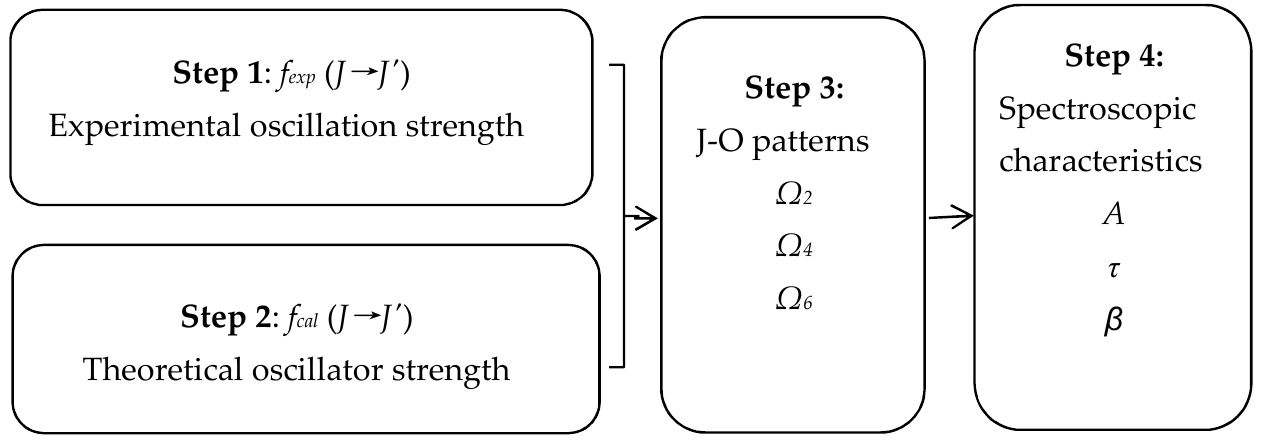
Figure 6. the main steps of Judd–Ofelt treatment on PMN-32PT: Ho 3+ /Yb 3+ . Figure 6. The main steps of Judd–Ofelt treatment on PMN-32PT: Ho 3+ /Yb 3+